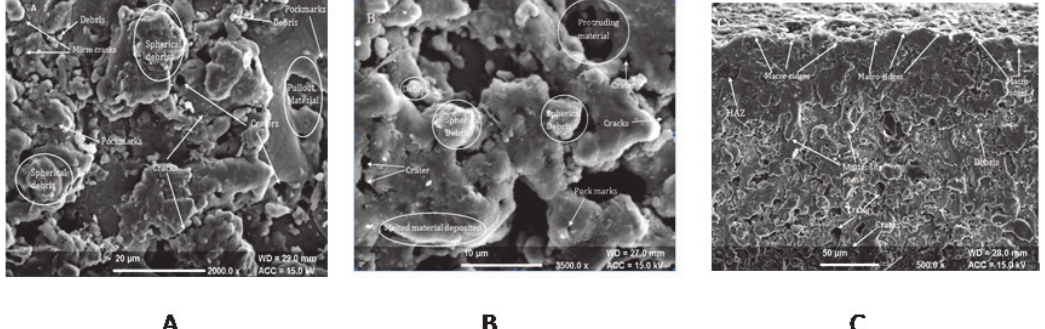
Fig. 7. SEM Micrograph of A 4 B 2 C 4 D 4 E 2 F 4 WEDM-cut surface of Inconel 825 at different cross